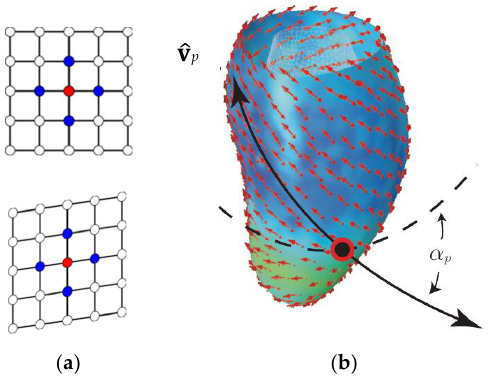
Figure 4. ( a ) First order neighborhood (in blue) relative to the evaluation point (in red) in a landmark-grid detail (either Endo- or Epi-) showed in the undeformed (diastole) and deformed state (systole). ( b ) Plane strain tensor U p is calculated on the red point using the displacement vectors of the blue ones. The PSD ˆ v p is then identified upon the eigen decomposition of U p . Then, the angle α p is computed with regard to the circumferential direction (dotted line). Modified from